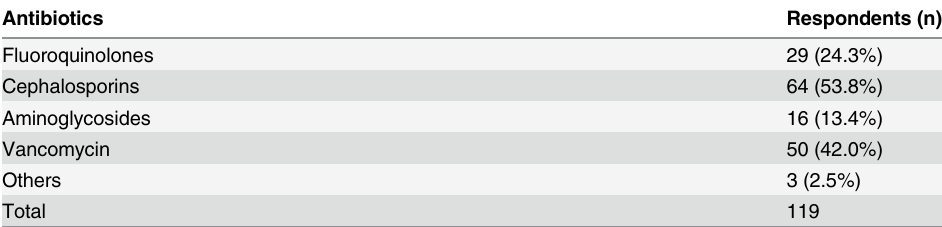
Table 4. Choice of antibiotics for intraocular administration.